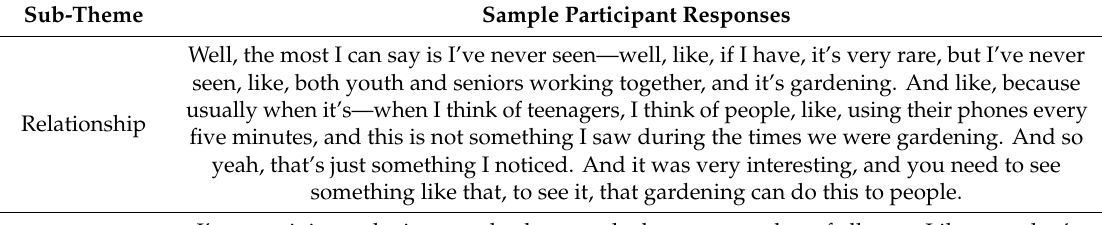
Table 1. Theme: Table 1. Theme: connections.